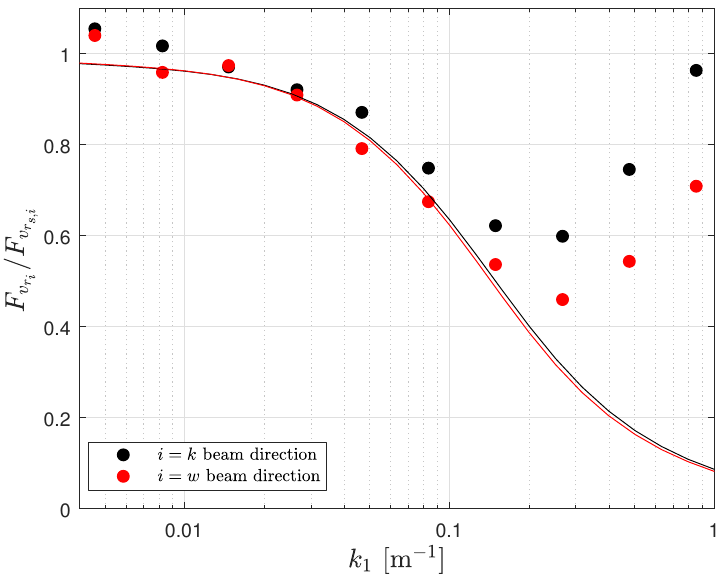
Figure 11. Radial velocity spectra ratio of the WindScanners to the sonic anemometer for each WindScanner beam as function of wavenumber. In solid lines, the theoretical spectral ratio is shown for each WindScanner beam for 290 ◦ winds assuming z R / L =